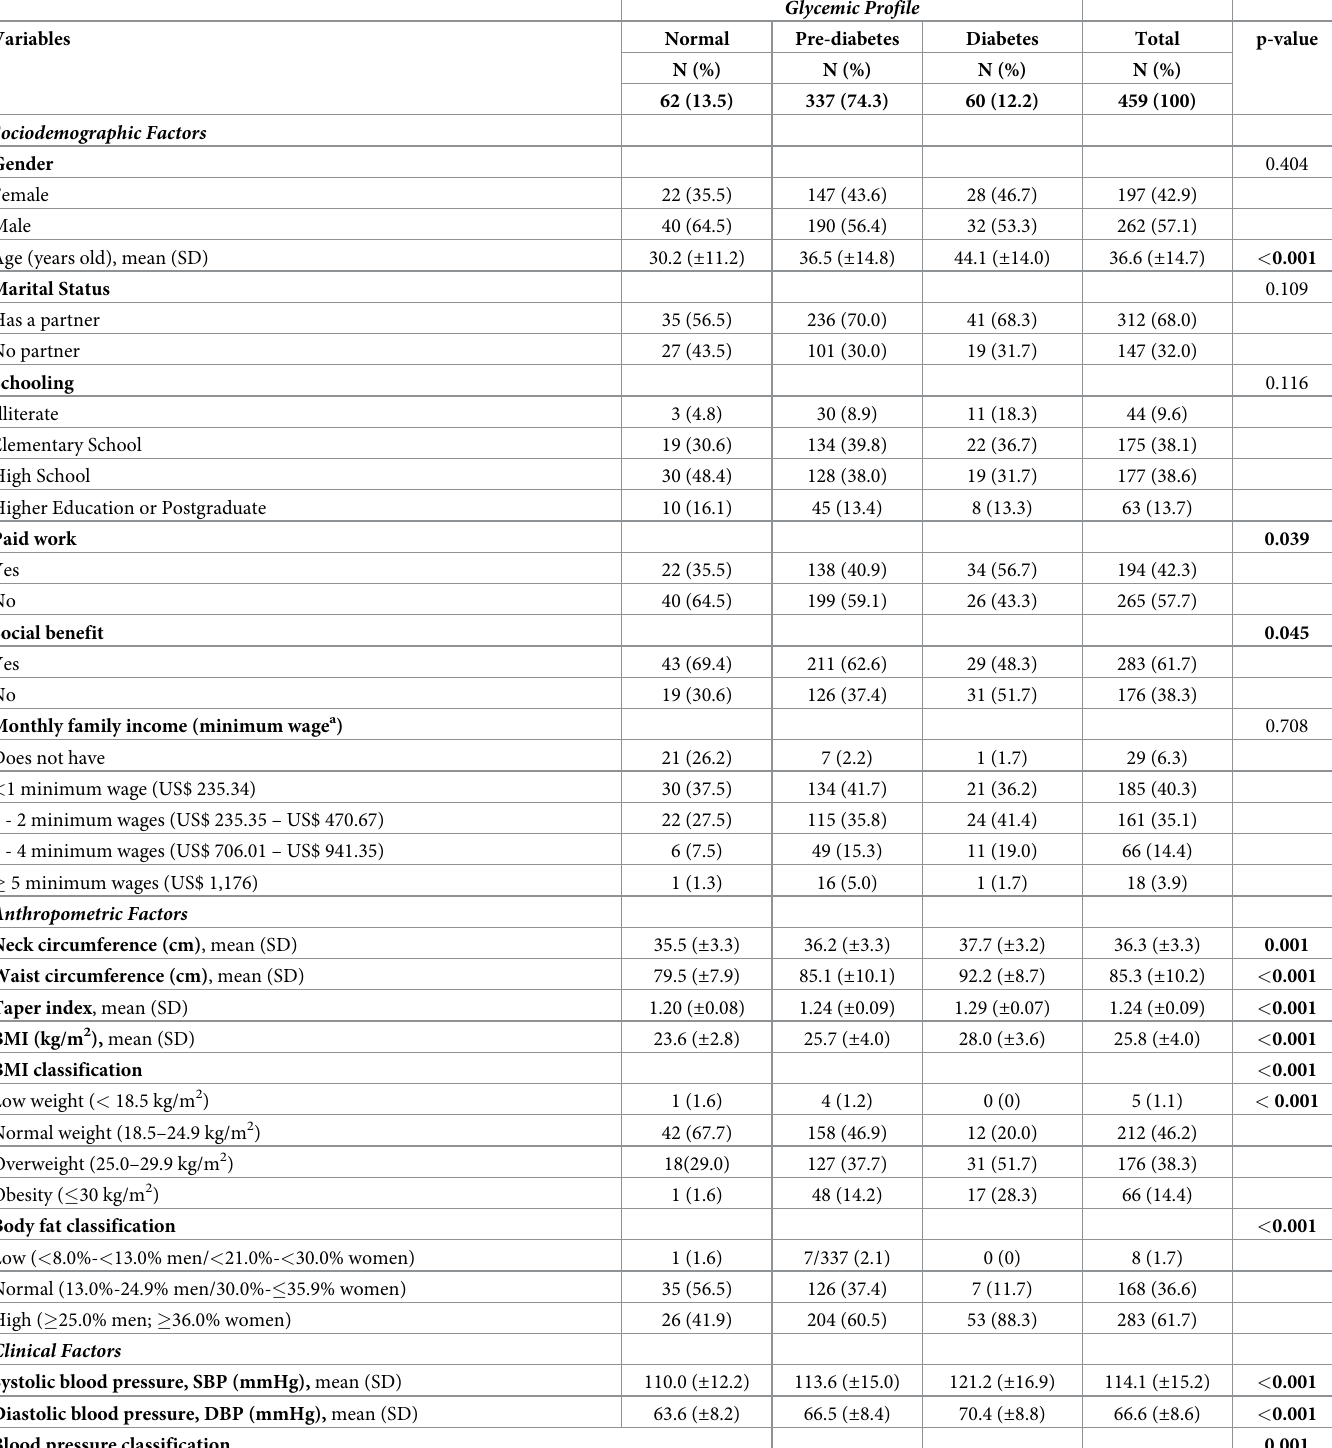
Table 1. Categorization of the glycemic profile of indigenous Munduruku according to the sociodemographic and anthropometric variables, clinical factors, habits and lifestyle, and family